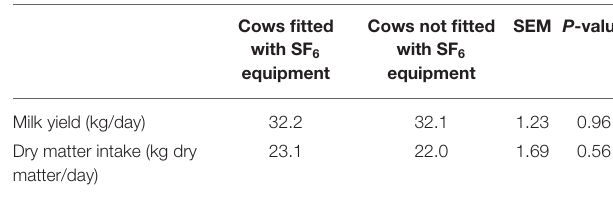
TABLE 5 | Milk yield and dry matter intake of dairy cows fitted or not with sulfur hexafluoride (SF 6 )